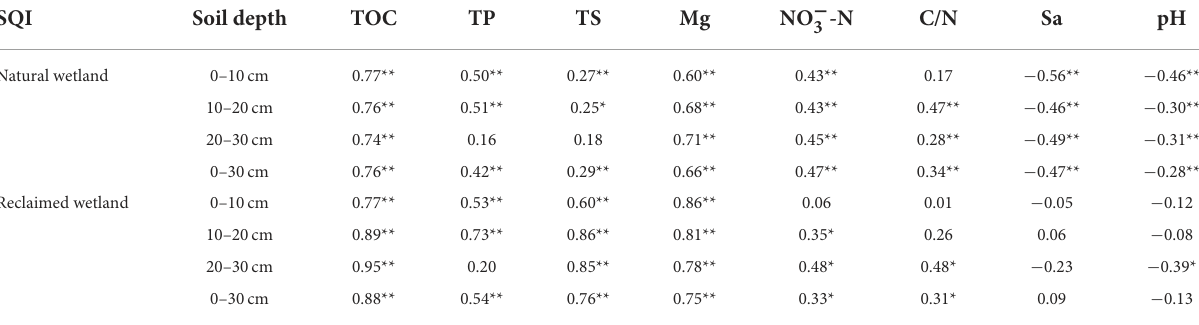
TABLE 4 Pearson relations of SQI with the soil indexes in MDS. SQI Soil depth TOC Natural wetland 0–10cm